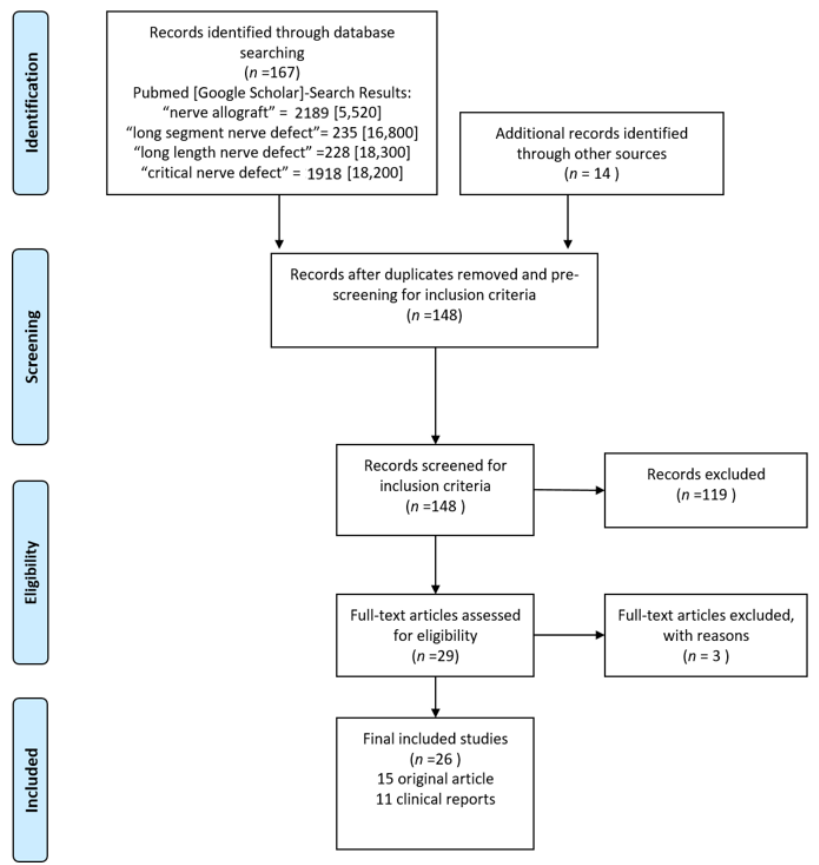
Figure 1. PRISMA flow chart for peripheral nerve defects extending 4.0 cm in length and reconstruc- tion by cadaveric processed/unprocessed allografts accordingly to the PRIMSA statements described by Moher et al. [37].